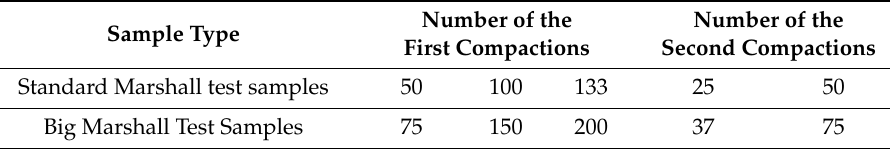
Table 3. Correspondence of compaction times of two types of Marshall samples.